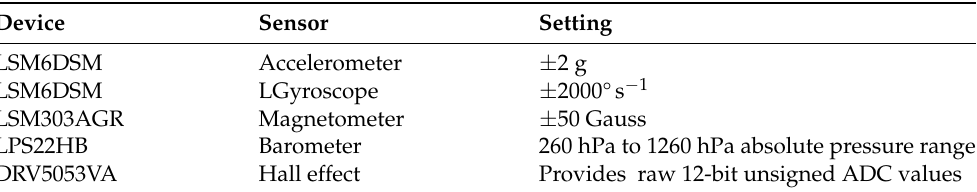
Table 2. Sensor devices and their settings as configured in the initialization routine prior to the start of a